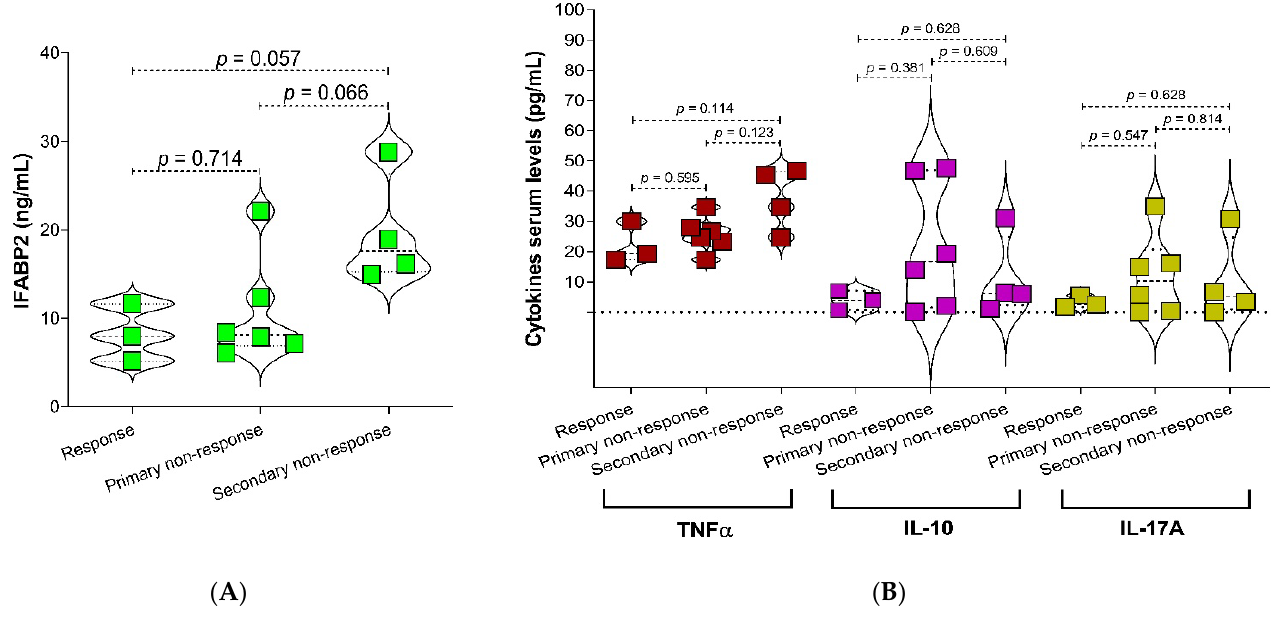
Figure 3. Association of serum levels of IFABP2 and cytokines according to clinical phenotype in RA patients with treatment. ( A ) IFABP2, ( B ) Cytokines (TNF- α , IL-10, and IL-17A). Statistical analyses were performed by Mann-Whitney U test. p -Value < 0.05 was considered statistically significant.